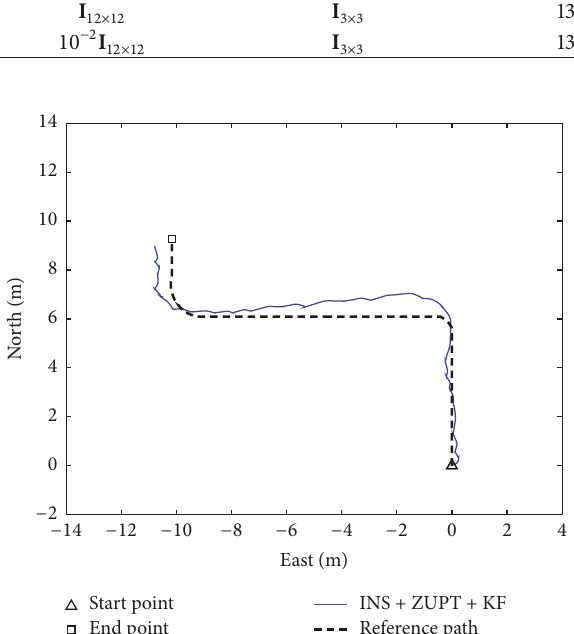
Figure 3: Trajectory measured by INS + ZUPT + KF for the first group of possible parameters (Group 1).